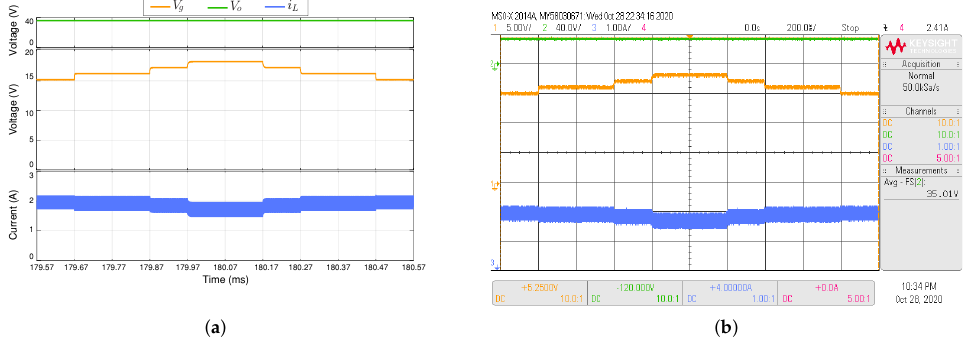
Figure 7. Simulated ( a ) and experimental ( b ) responses of the discrete-time sliding-mode current control when the reference v ref changes with steps of 1 V between 15 V to 18 V while the output voltage ( V o = 36 V) ensures a boost operation. CH1: v g (5 V/div), CH2: V o (40 V/div), CH3: i L (1 A/div) and a time base of 200 ms.